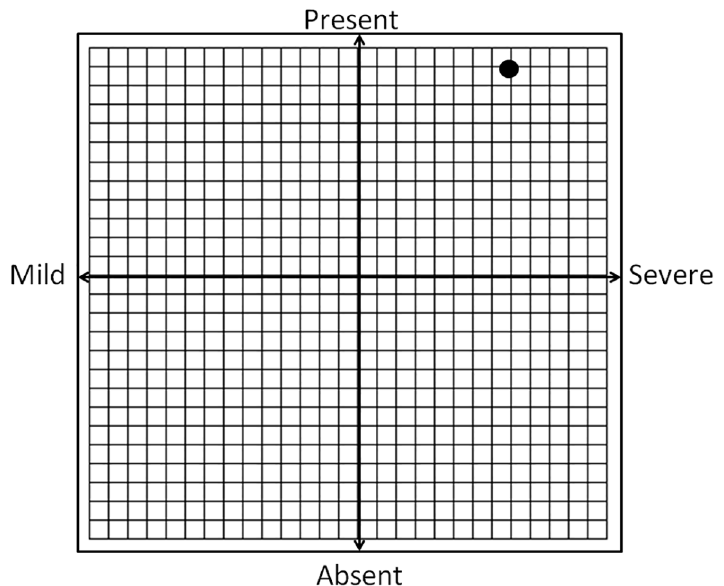
Figure 2. The conceptual link between the presence and the severity of withdrawal symptoms in exercise addiction, indicating the approximate position of Evelyn's scores with the black